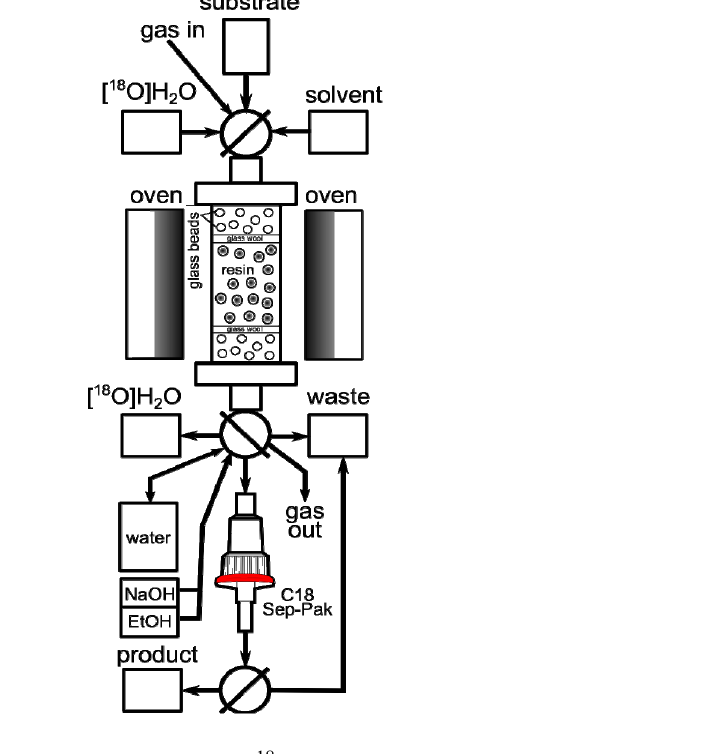
Table 7. Automated on-column radiosynthesis of [ 18 F]FDG on 120 GBq scale: Quality Control. Analysis Result Requirement (European